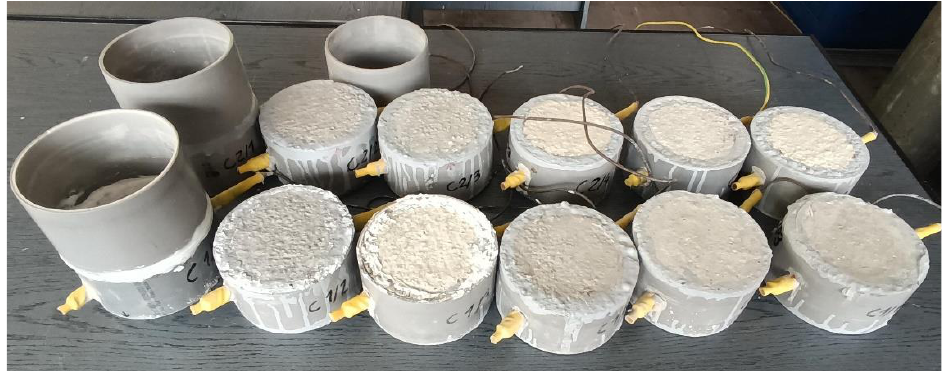
Figure 1. Specimens of both types of concrete prepared for testing during